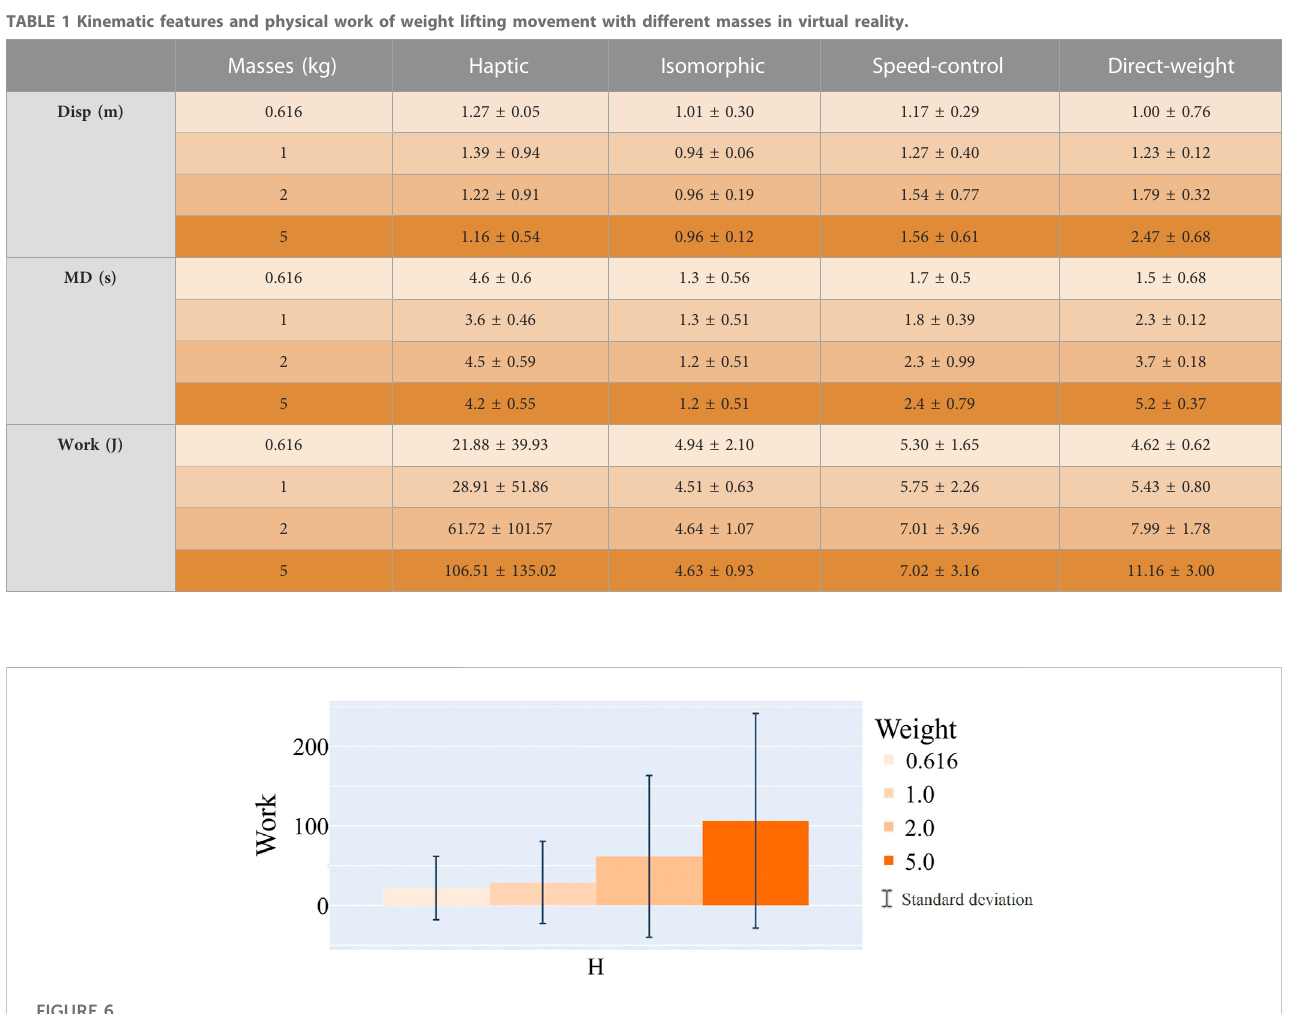
FIGURE 6 Mean ± SD of work for 20 users for the reference (Haptic)